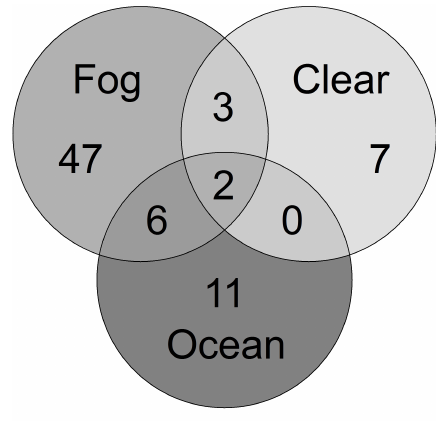
Fig. 6. Venn diagram constructed from MOTHUR OTU analysis of coastal aerosol (during foggy and clear conditions) and ocean sequence libraries (Maine, USA), using the average neighbor algo- rithm with 97% similarity cut-off.